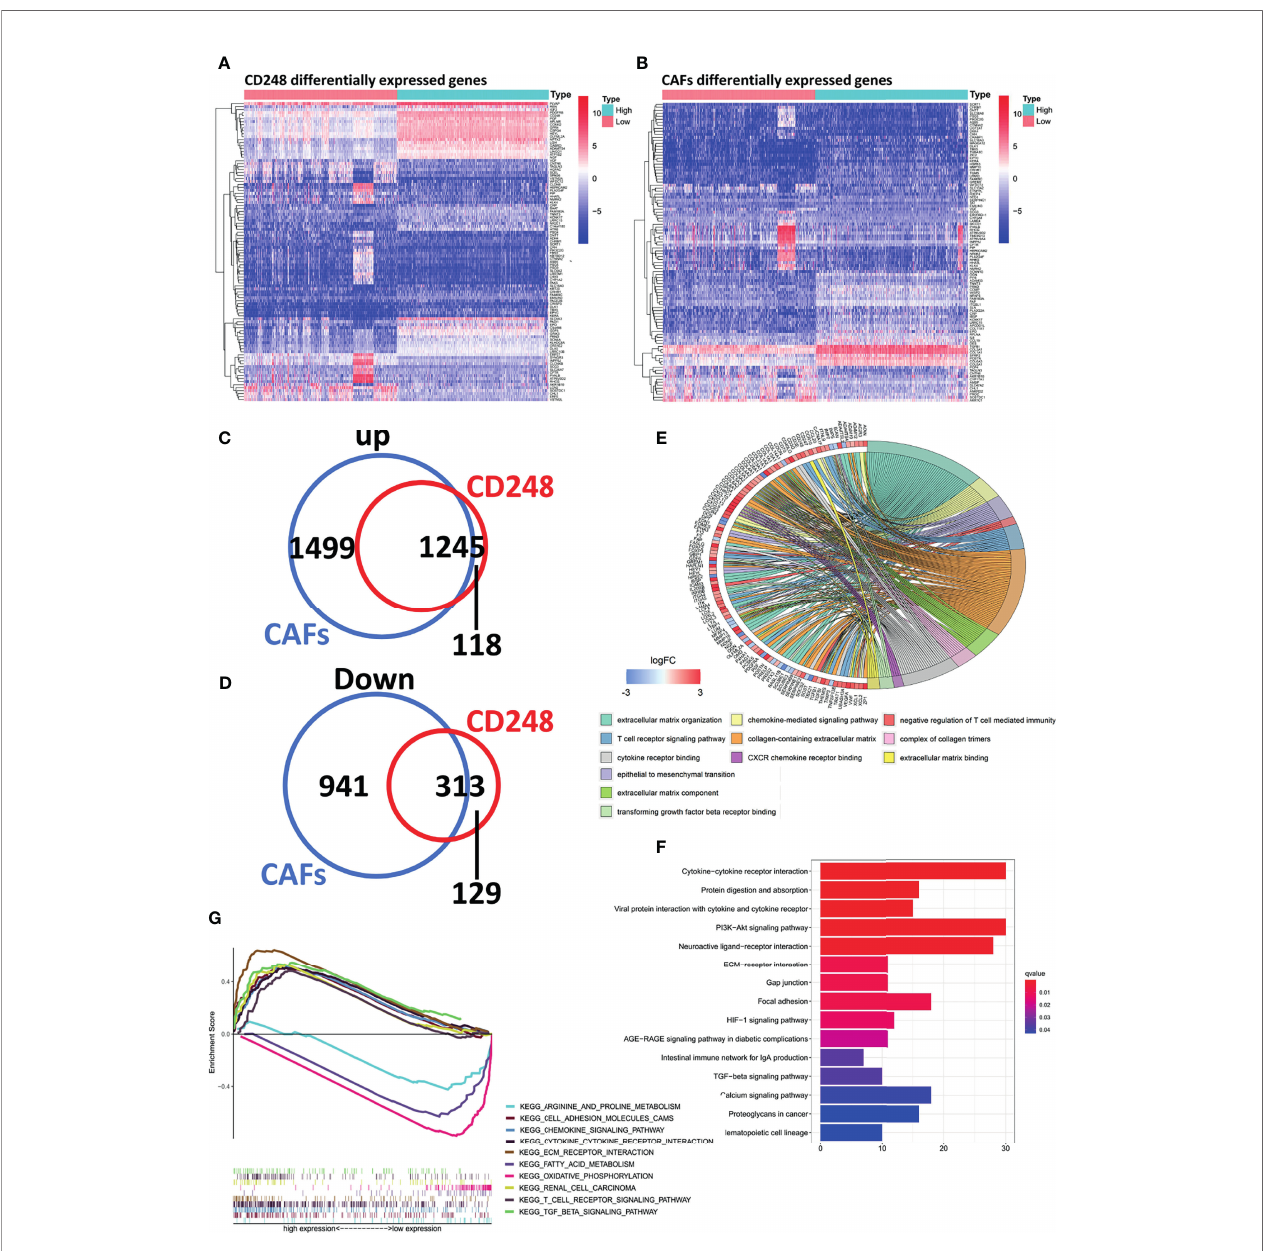
FIGURE 6 | Recognition of regulatory DEGs for CD248 + CAFs and enrichment analysis. (A) Heatmap showing DEGs based on median CD248 expression. (B) Heatmap showing DEGs based on the median CAF in fi ltration. (C, D) The intersection of DEGs associated between CD248 and CAFs. (E) GO function enrichment analysis. (F) KEGG pathway analysis. (G) GSEA of KEGG pathway analysis. p < 0.05 was considered statistically signi fi